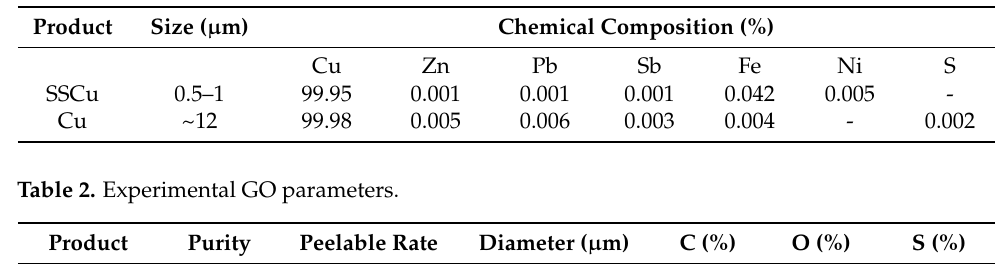
Table 1. Experimental Cu parameters.